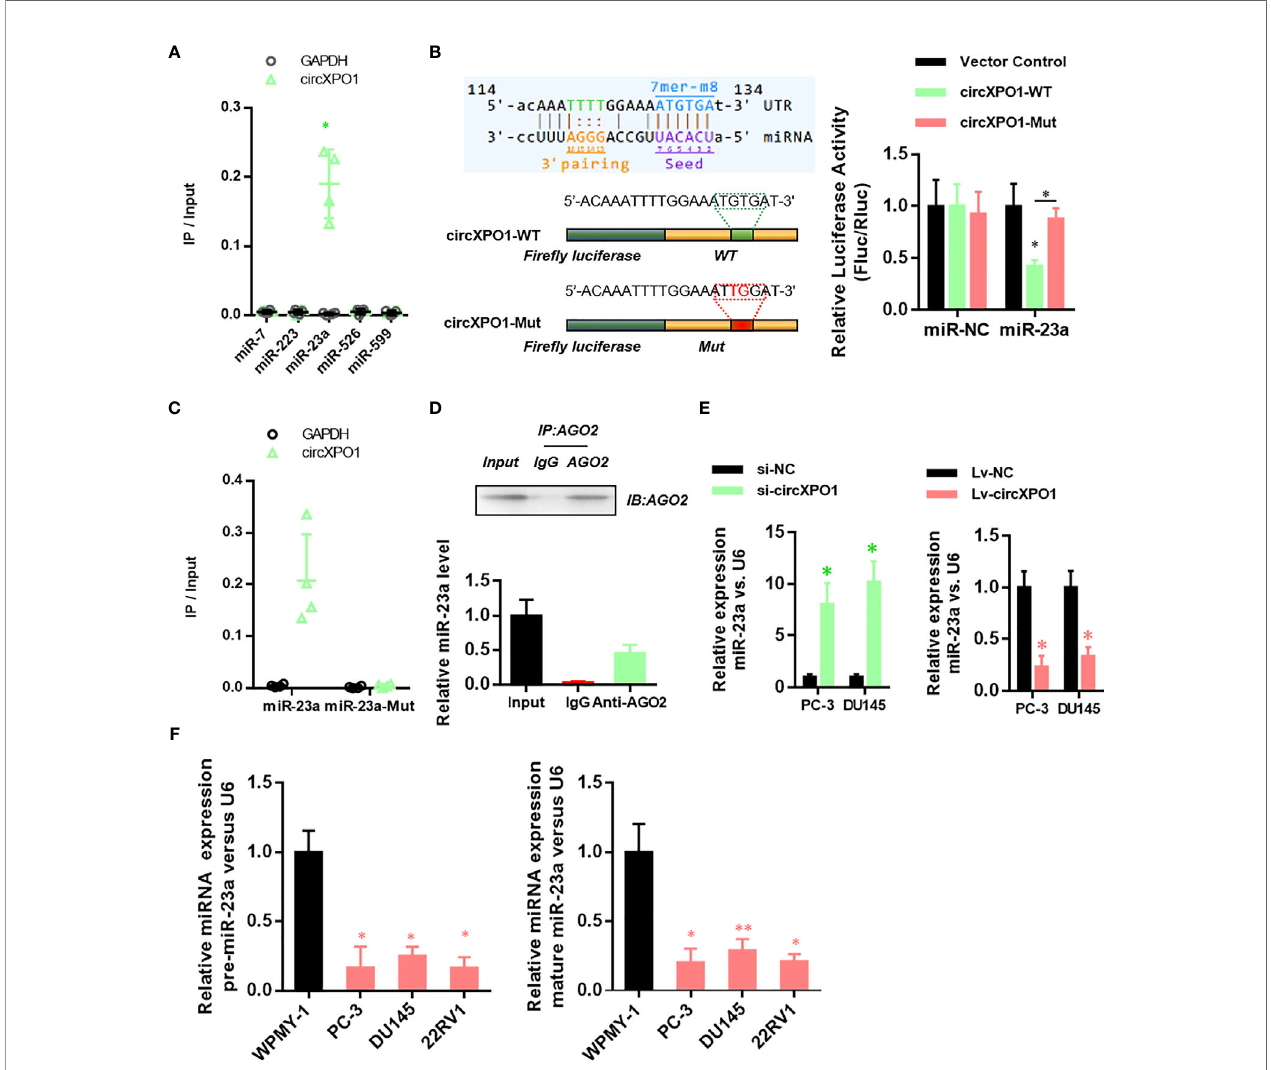
FIGURE 3 | CircXPO-1 targeted miR-23a. (A) RNA pull-down was conducted to identify the target microRNA of circXPO-1. (B) DU145 cells were cotransfected with the luciferase vectors expressing the wild-type or mutant circXPO-1 and miR-23a mimics or negative control mimics. The luciferase signals were detected at 48 h after transfection. (C) RNA pull-down with wild-type or mutant miR-23a was performed to examine the interaction between miR-23a and circXPO1. (D) AGO2 immunoprecipitation was conducted to examine the enrichment of miR-23a and circXPO1 in the AGO2 complex. (E) qRT-PCR was performed to determine miR- 23a levels in PC-3 or DU145 cells in response to circXPO1 knockdown or overexpression. * P < 0.05 vs. si-NC; n = 3. (F) qRT-PCR was conducted to determine miR-23a levels in normal prostatic cell line WPMY-1 and pancreatic cancer cell lines (PC-3, DU145, 22RV1). * P < 0.05, ** P < 0.01, vs. WPMY-1; n =